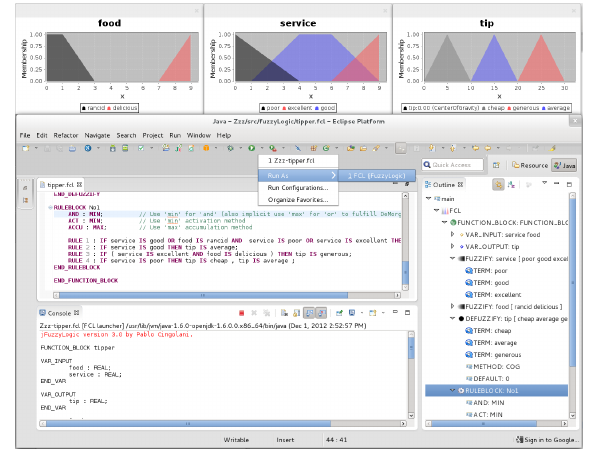
Fig. 7. Eclipse plugin when an FCL program is